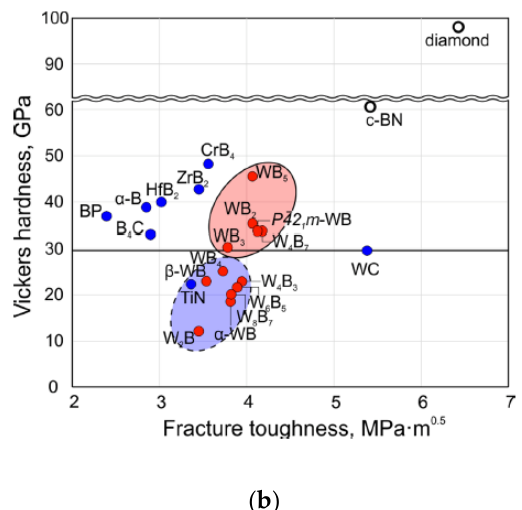
Figure 19. ( a ) Flowchart of a genetic algorithm as USPEX [310]. ( b ) Ashby plot of predicted new W-B phases (red points) compared to known superhard materials (blue points) [309].